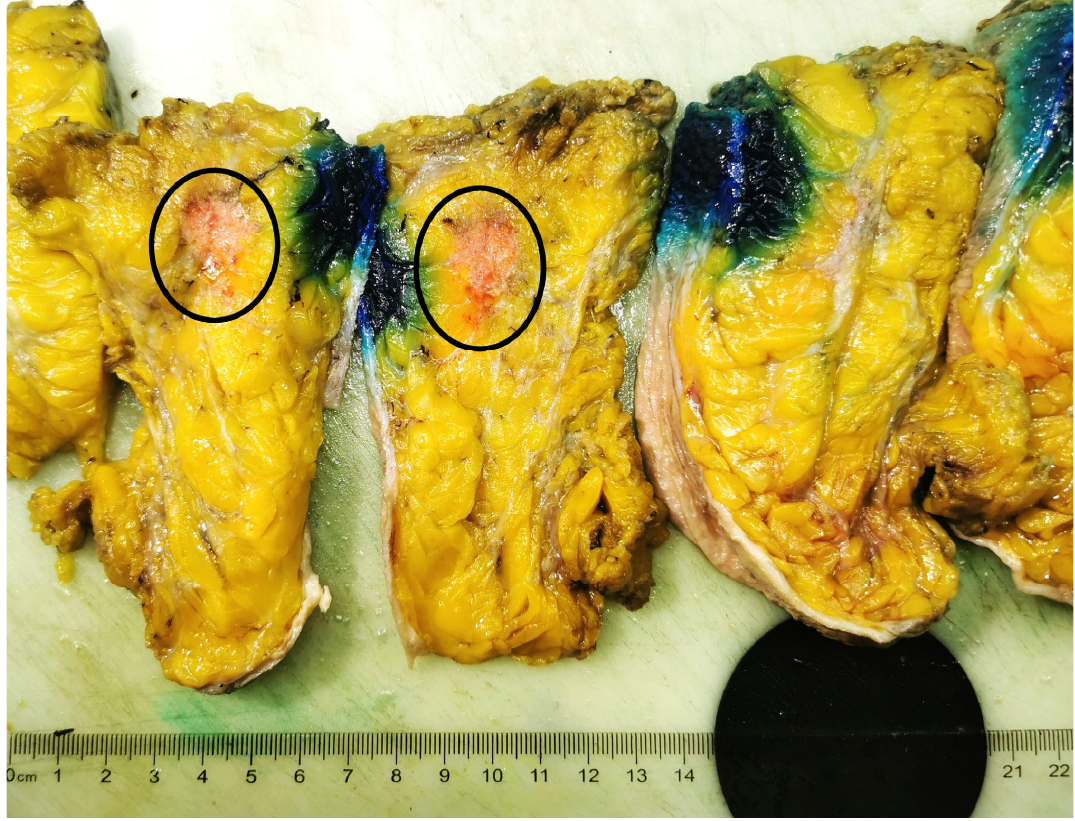
Figure 3. Gross examination of the mastectomy specimen revealing a nodular tumoral mass with in fi ltrative margins (within the black circle), located at the level of the SE (supero-external) quadrant of the breast.